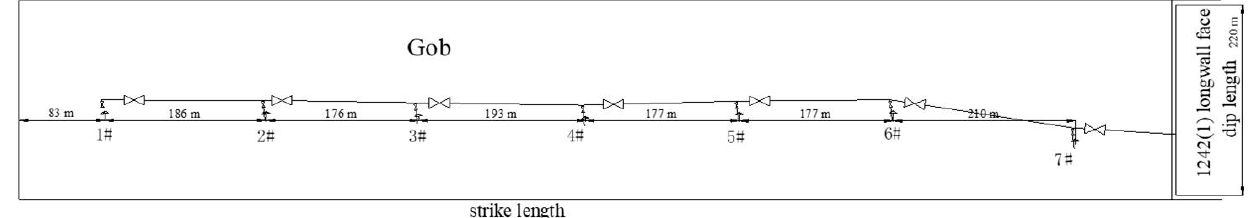
Figure 3. SGV stations in LW1242(1) panel in the Huainan coalfield